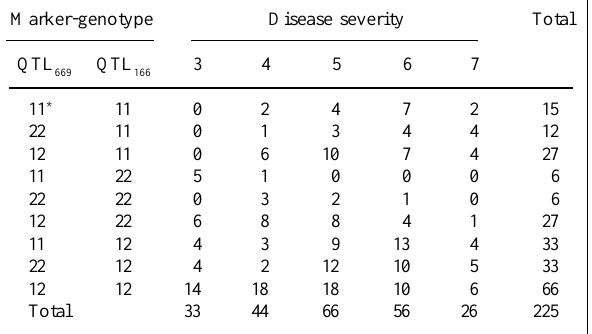
*1 and 2 denote alleles from L10 and L20, respectively.